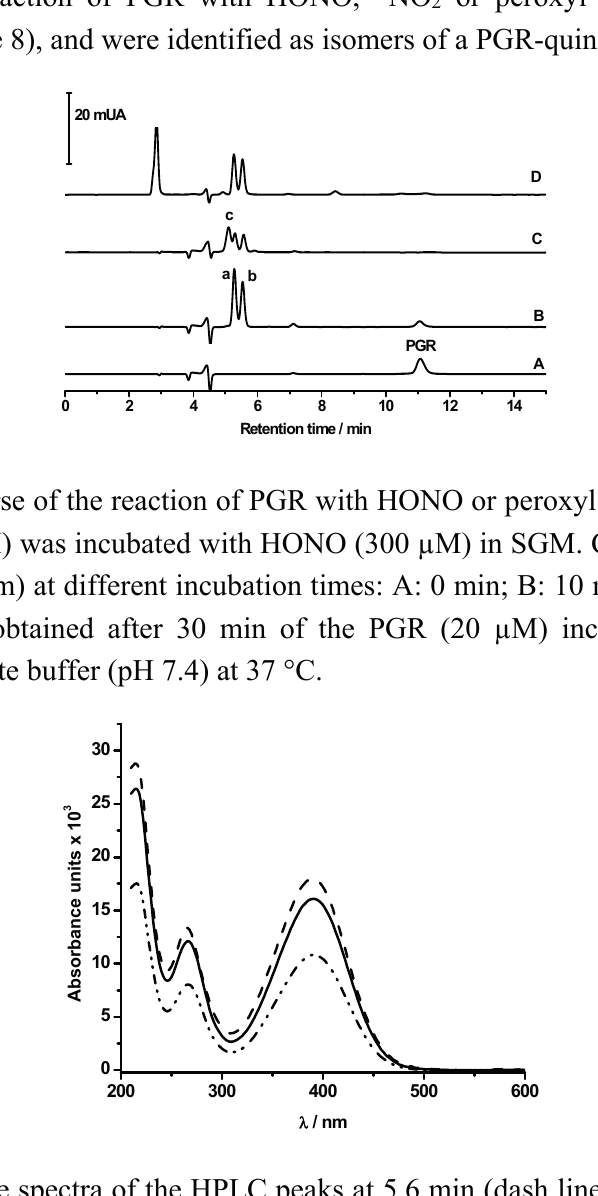
Figure 8. UV-visible spectra of the HPLC peaks at 5.6 min (dash line) and 5.1 (solid line) obtained during the reaction of PGR (20 µM) and HONO (300 µM). Dash-dot-dot line: UV-visible spectrum of the HPLC peak at 5.6 min obtained from the reaction of PGR (20 µM) and AAPH-derived peroxyl